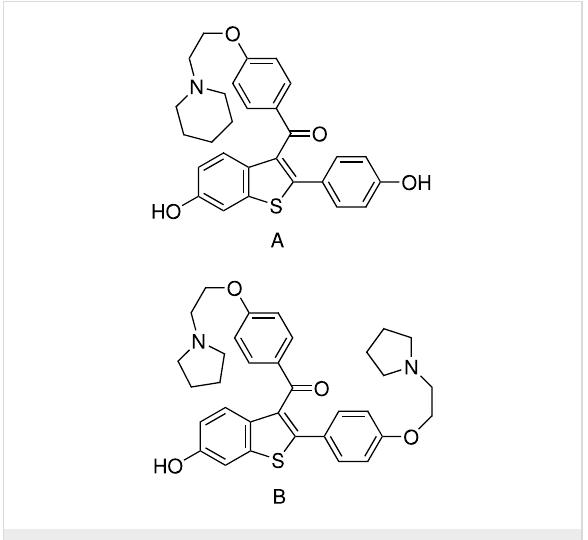
Figure 1: Acyl benzothiophenes of pharmacological